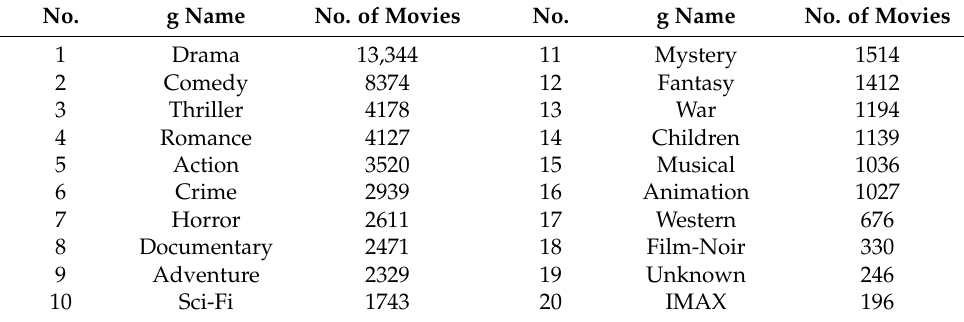
Table 5. Genre name in ML-20 M dataset and number of movies per genre.